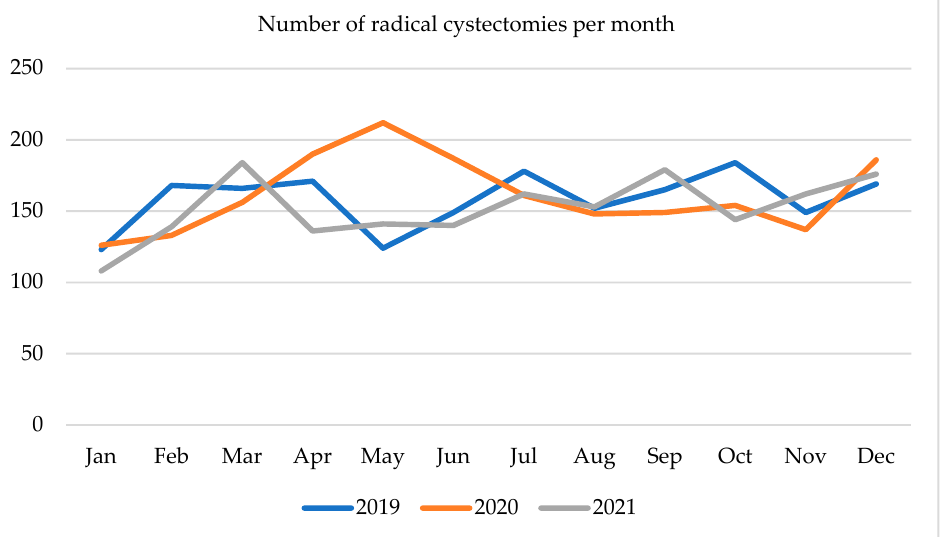
Figure 2. Number of radical cystectomies per month in 2019–2021.